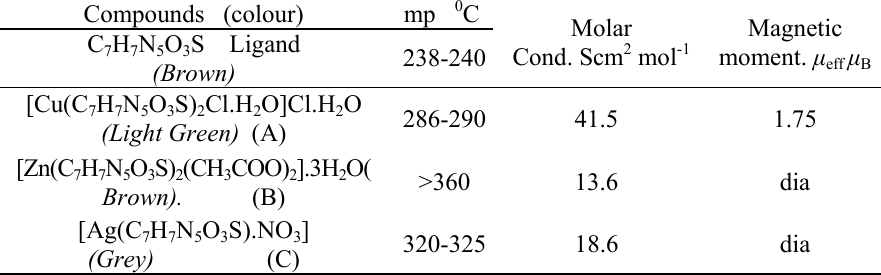
Table 2. Molar conductance and Magnetic properties of metal complexes